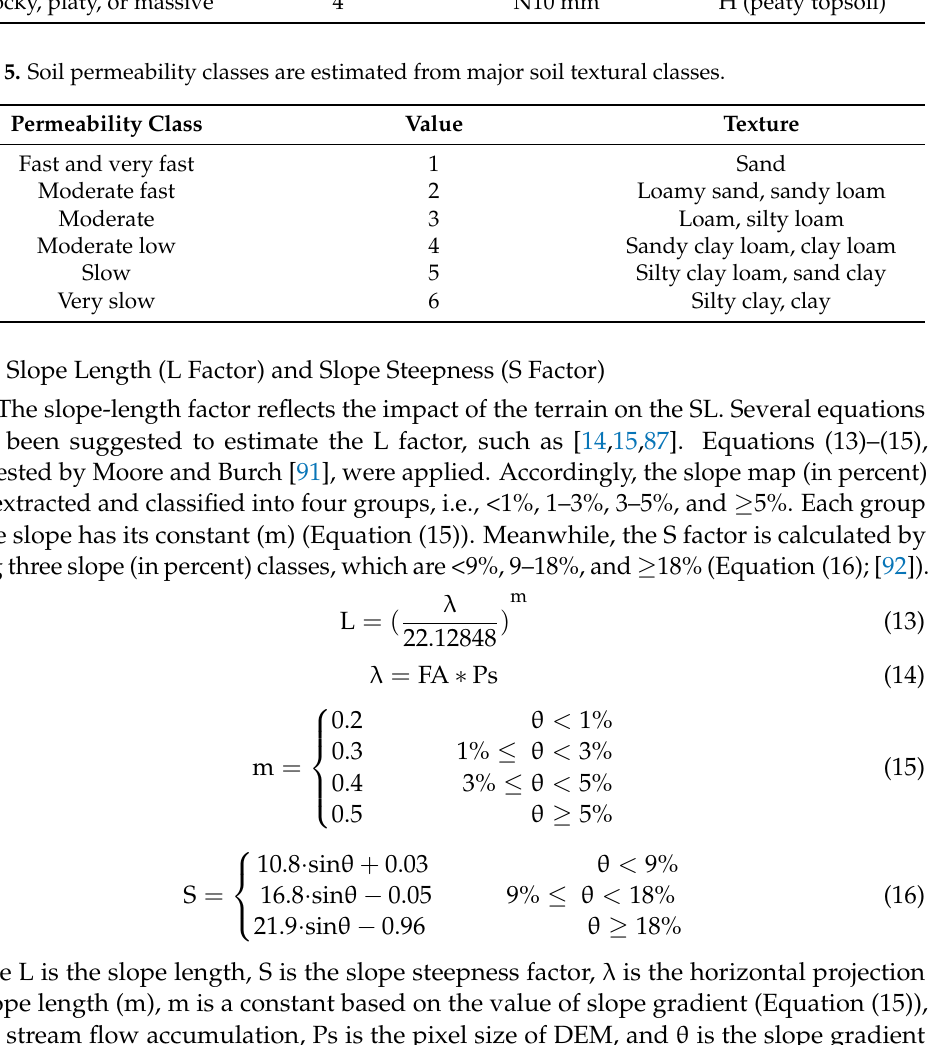
Medium or coarse granular